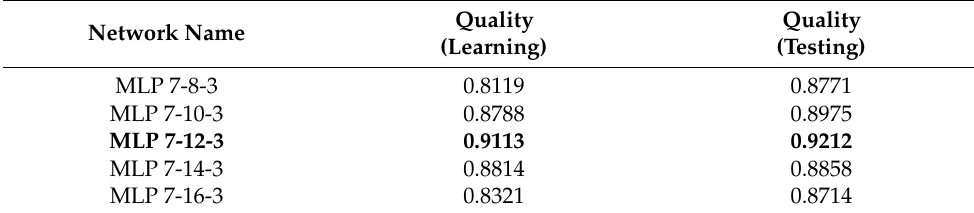
Table 4. Selected ANN quality assessment (the best one is marked in bold).